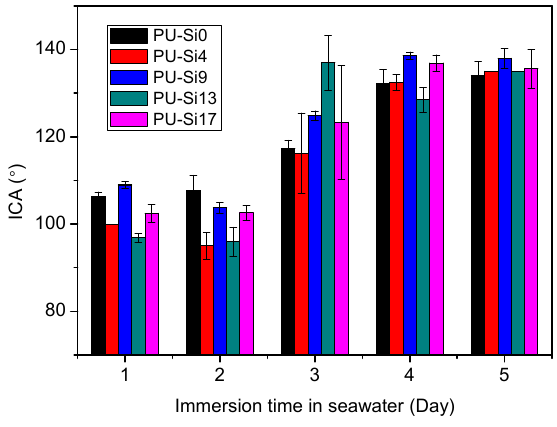
Figure 17. ICA of the PU-Sis samples during immersion in seawater.